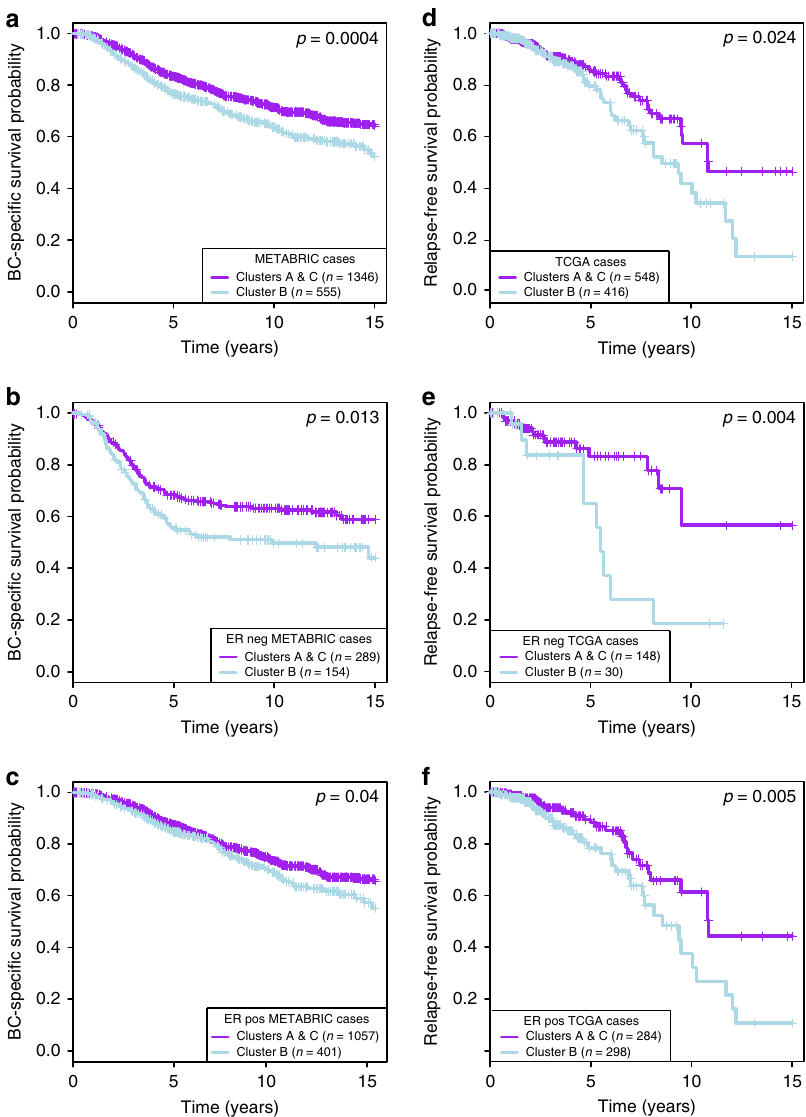
Fig. 2 Immune clusters are associated with prognosis. Kaplan – Meier survival curves for Cluster B (light blue) and Clusters A and C (purple). In all METABRIC ( a ) and TCGA ( d ) samples; in ER negative ( b , e ) and ER positive ( c , f ). p values are from log-rank tests. Kaplan – Meier display breast cancer- speci fi c survival for the METABRIC and relapse-free survival for the (Supplementary Fig. 3E, F) separately. To re fi ne our observation, we plotted patient survival according to Cluster B (light blue) vs Clusters A and C (purple) and con fi rmed a clear and signi fi cant worse prognosis for patients in Cluster B (Fig. 2). We further validated this result in four additional cohorts with relevant survival data: TAI ( n = 327), VDX ( n = 344), STK ( n = 159), and UPP ( n = 251) (Supplementary Fig. 4). We concluded that immune clusters associate with prognosis both in ER-negative and ER-positive breast cancers.